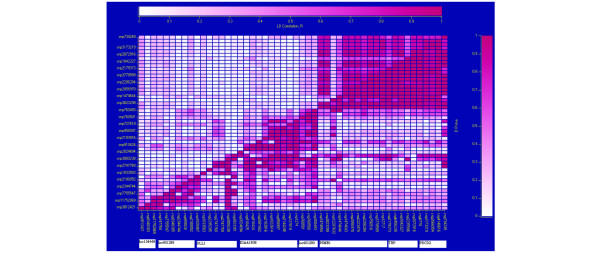
Linkage disequilibrium plot of the IDDM8 region in controls. The plot shows both linkage disequilibrium correlation and D' as measures of linkage disequilibrium across the IDDM8 region.